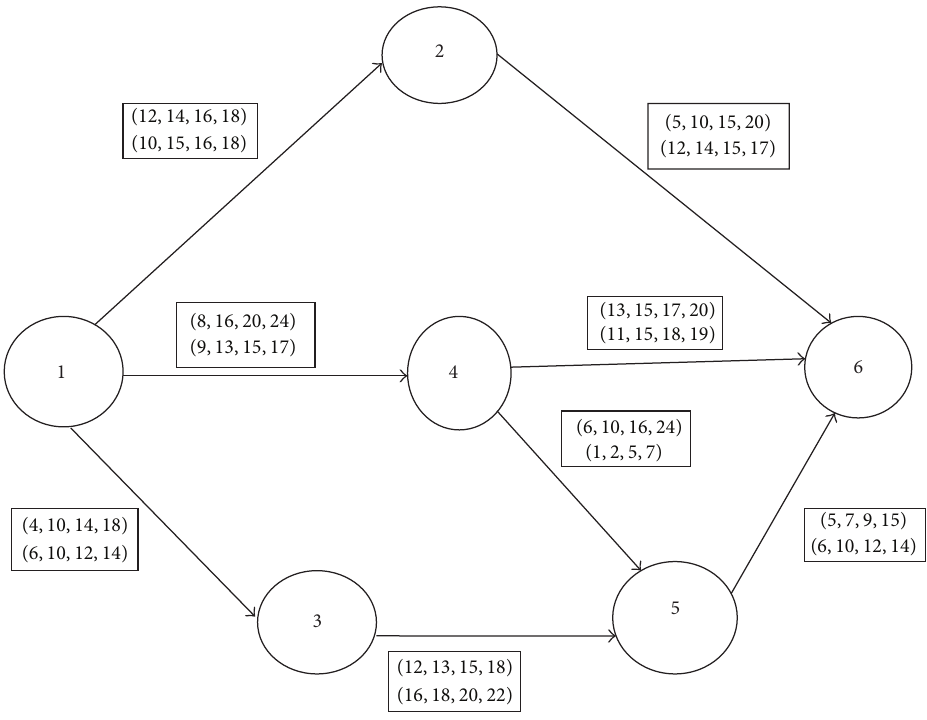
Figure 2: Illustrative